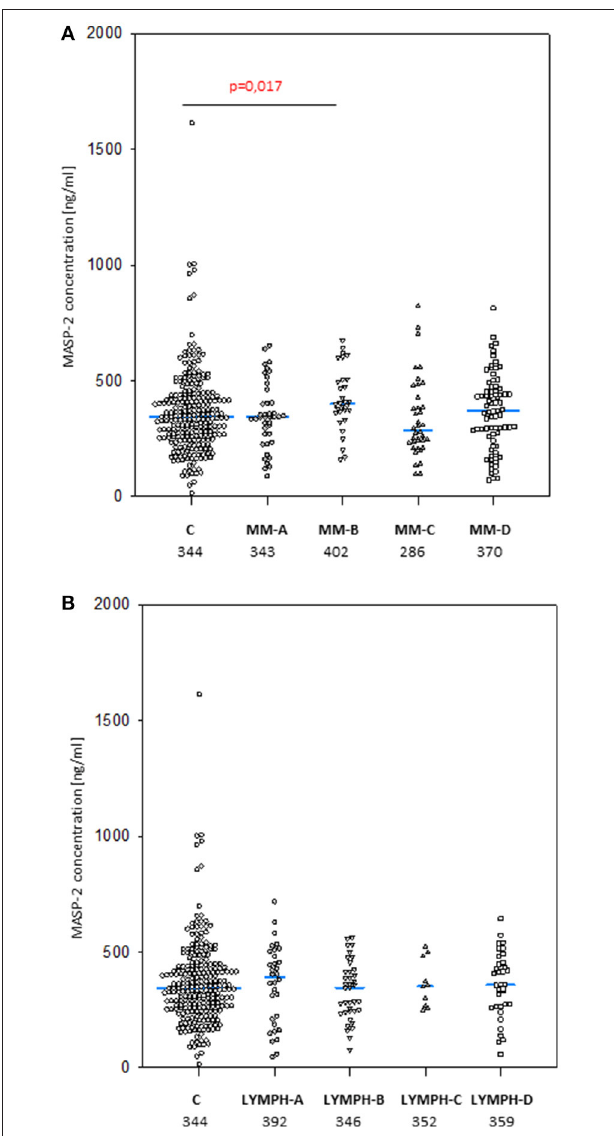
FIGURE 6 | MASP-2 serum concentrations in patients (before conditioning chemotherapy) and controls. Blue bars present median values (given below group descriptions). (A) controls (C) vs. multiple myeloma (MM) patients; (B) —controls vs. lymphoma (LYMPH) patients. MM-A, LYMPH-A: patients who experienced infections with proven bacteremia; MM-B, LYMPH-B: patients who experienced infections with no bacteremia; MM-C, LYMPH-C: patients